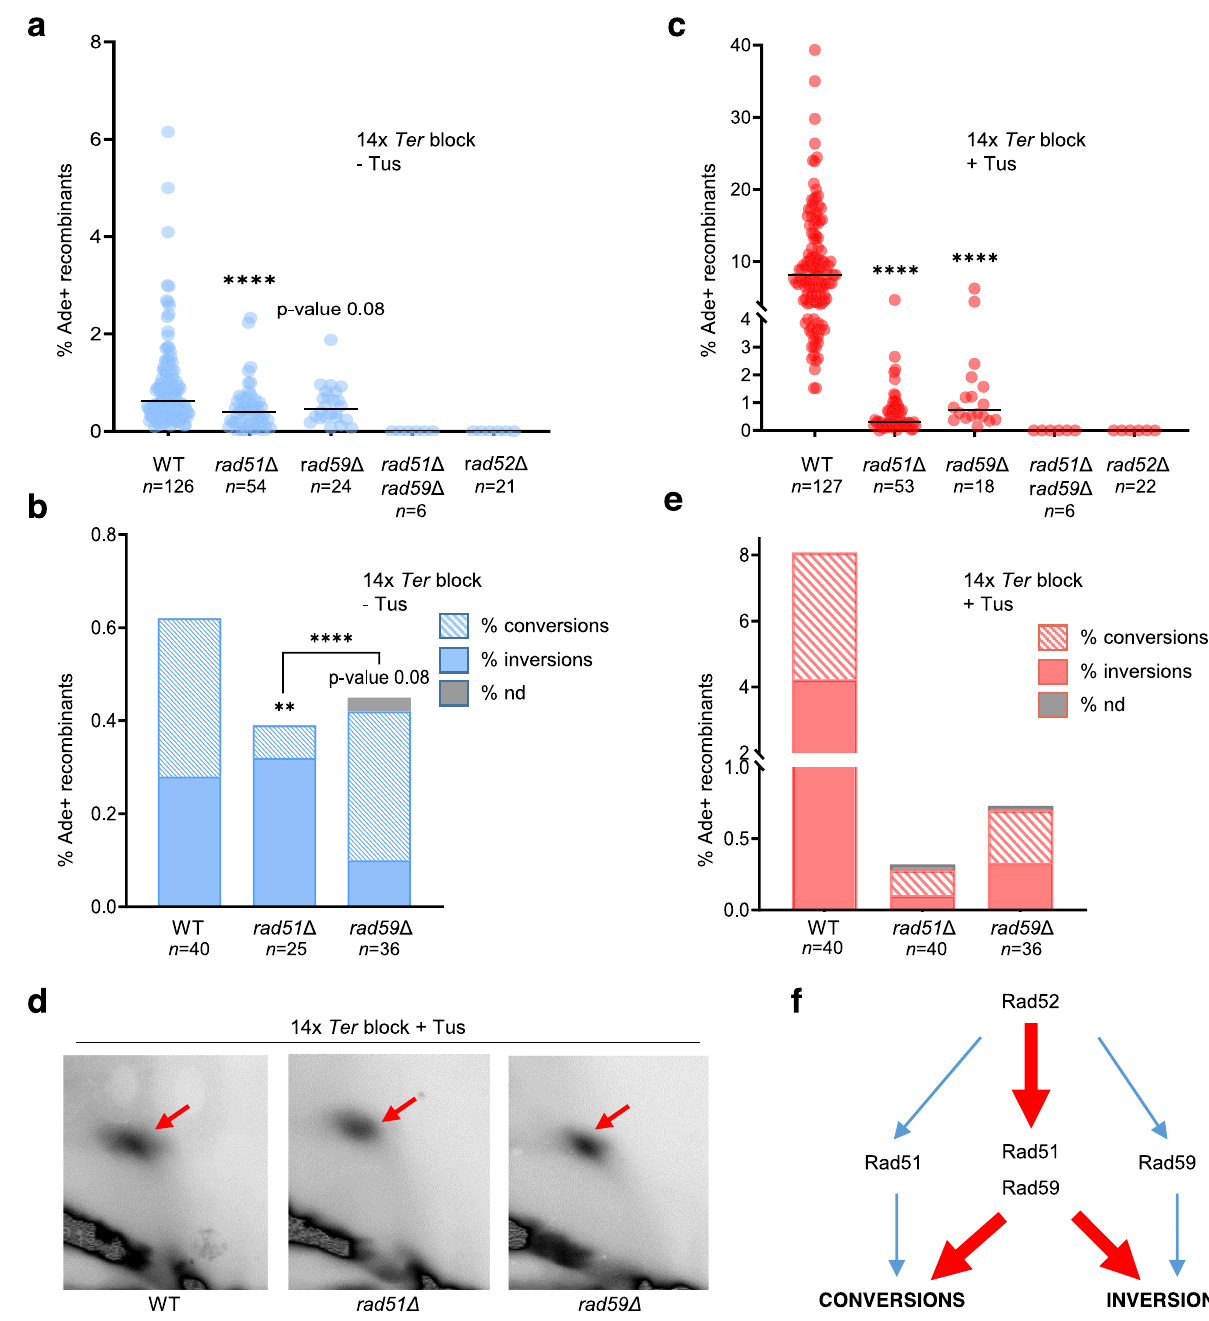
Fig. 2 NAHR at the Tus/ Ter barrier relies on the cooperation of Rad51 and Rad59. a Spontaneous Ade + recombination frequencies in WT and mutant strains. Black lines indicate medians; n indicates the number of colonies tested. p -values were obtained on log-transformed data by one-way ANOVA with a Bonferroni post-test and are relative to the WT strain in the same condition. They are reported as stars when signi fi cant with: **** p -value < 0.0001. Exact p -values are reported in Supplementary Data 1. b Distribution of independent spontaneous recombination events scored by PCR; nd indicates structure could not be determined by PCR; n indicates the number of independent Ade + recombinants tested. p -values, reported as stars when signi fi cant, were obtained by Chi-square test: ** p -value < 0.005, **** p -value < 0.0001. Exact p -values are reported in Supplementary Data 1. c Tus-induced Ade + recombination frequencies in WT and mutant strains. Black lines indicate medians; n indicates the number of colonies tested. P -values were obtained on log-transformed data by one-way ANOVA with a Bonferroni post-test and are relative to the WT strain in the same condition. They are reported as stars when signi fi cant with **** p -value < 0.0001. d 2D gel analysis of replication intermediates showing similar fork arrest in the WT and mutant strains. Red arrows indicate the replication fork arrest on the arc of Y-shaped replication intermediates. e Distribution of events scored by PCR for Tus-induced recombinants. n indicates the number of independent Ade + recombinants tested. Data were analyzed by Chi-square test. Source data are provided as a Source Data fi le. f Contribution of Rad51, Rad52, and Rad59 to spontaneous (blue) and replication fork block-induced (red) NAHR pathways.